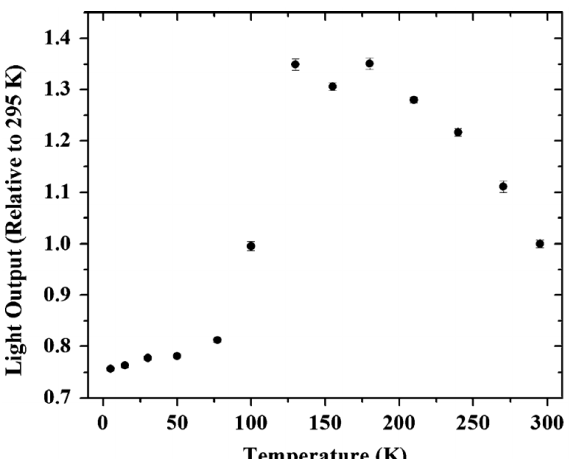
Figure 11. Evolution of estimated light output as a function of temperature for SrI 2 (Eu) crystal scintillator under 137 Cs gamma-ray excitation, as measured in Ref. [77]. Reprinted with permission from [77]. Copyright 2012